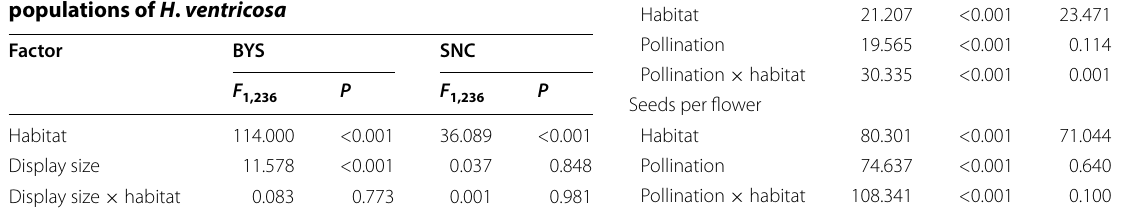
Fig. 1 Total pollinator visitation rate per flower per hour (mean in the forested and open patches in two populations of H . ventricosa . *** P < 0.001